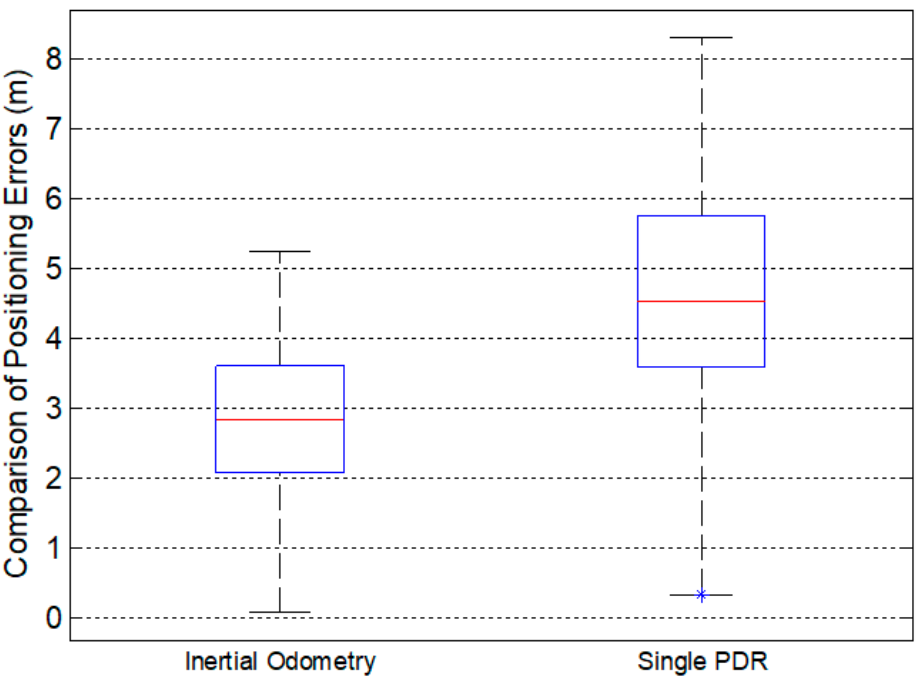
Figure 6. Error Comparison of Inertial Odometry and PDR. It can be found from Figure 7 that the proposed DLSE-assisted inertial odometry realizes much higher positioning accuracy under four different handheld modes; the realized average positioning errors are within 2.91 m (reading mode), 3.56 m (calling mode), 5.79 m (swaying mode), and 3.89 m (pocket mode) under the long-term test route, compared with the PAE algorithm with 3.47 m (reading mode), 4.13 m (calling mode), 7.22 m (swaying mode), and 4.34 m (pocket mode).